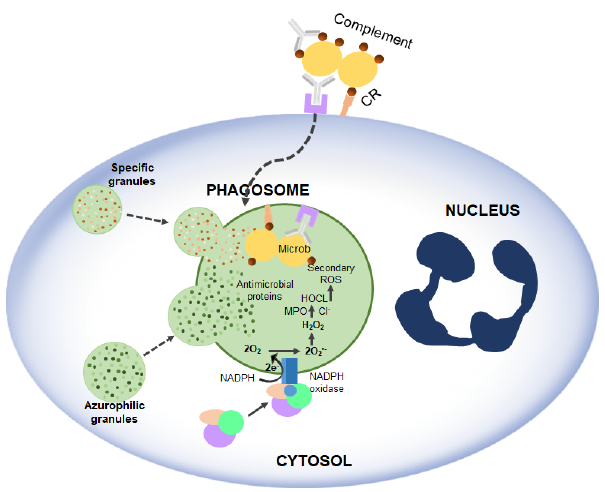
factor receptor 1.